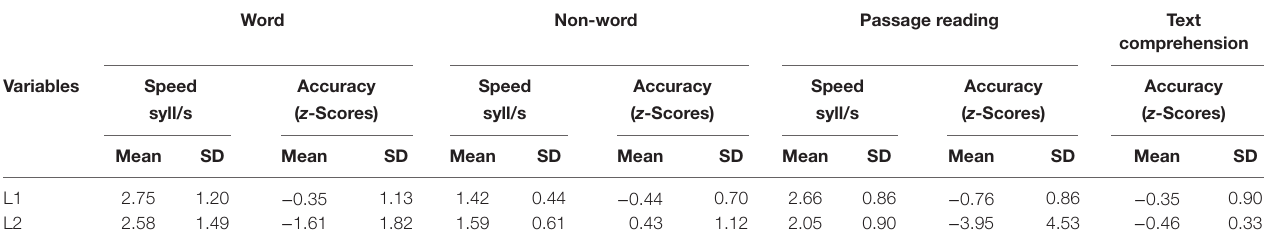
TaBle 5 | Reading and spelling performances in L2 children and in L1 peers matched for chronological age on the standardized reading tests. Word non-word Passage